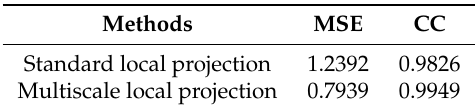
Table 1. Comparison of two algorithms for noise reduction.